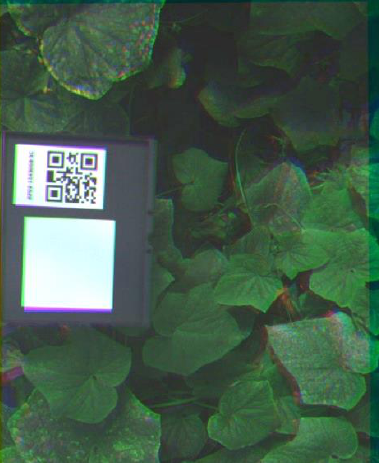
Figure 3. RGB composite made with the Micasense ® RedEdge multispectral images acquired over the MicaSense ® calibration panel.